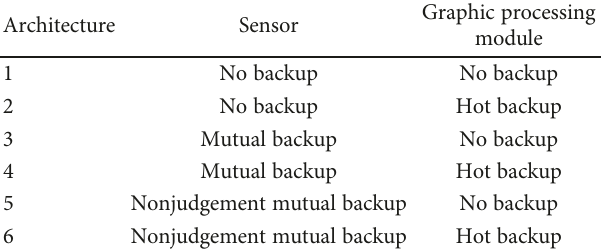
Figure 16: AADL reliability model of bilateral tolerant display function. Table 1: Design of di ff erent architectures for basic display function. Table 2: Design of di ff erent architectures for bilateral tolerant display